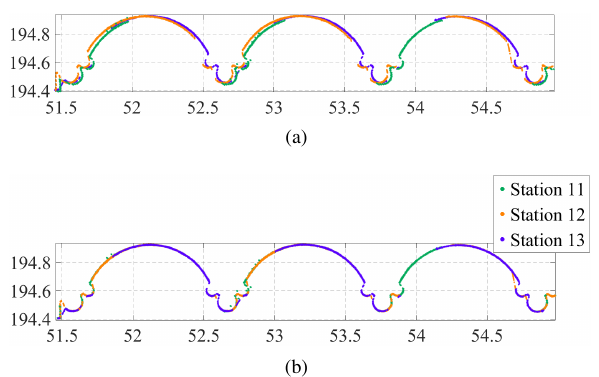
Figure 5. (a) Horizontal cross-section performed in SX10 directly georeferenced point clouds, above the three tympana. (b) Same section carried out in the aligned point clouds after indirect geo- referencing. Scales are in meters.